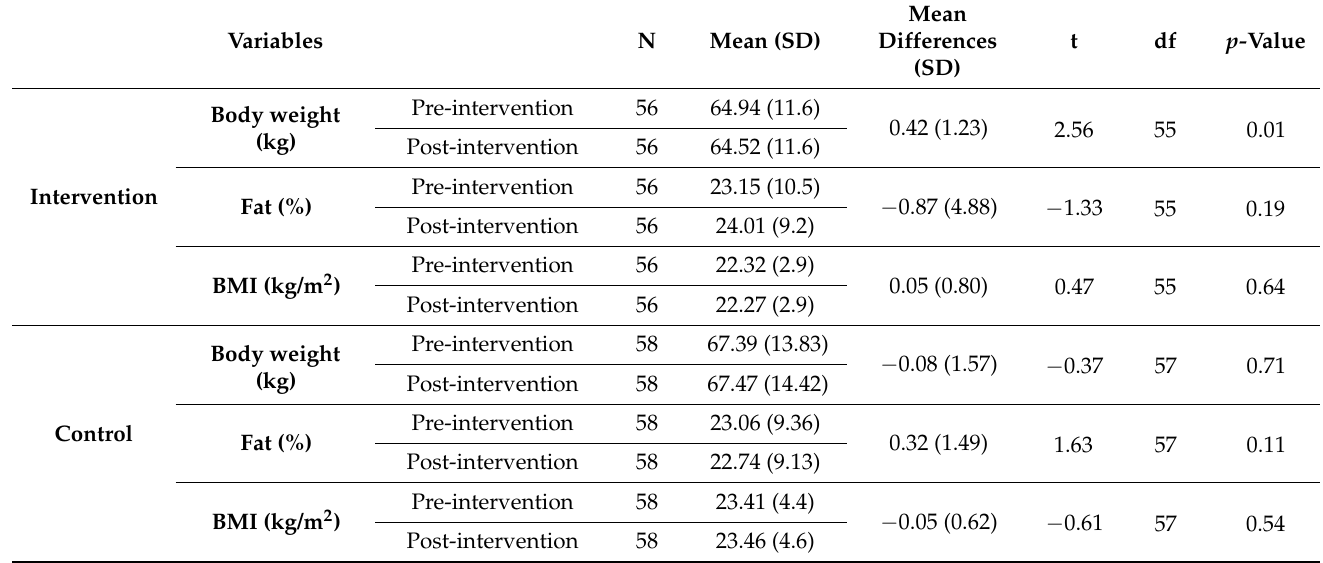
Table 3. Anthropometric variables for the intervention and control